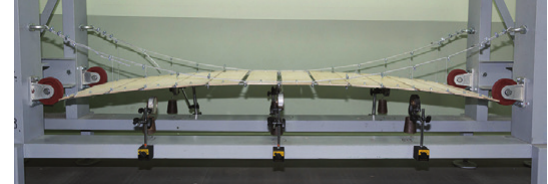
Fig. 2. Physical model, where plywood boards are placed with clearances and the deck behaves in bending in transversal direction only